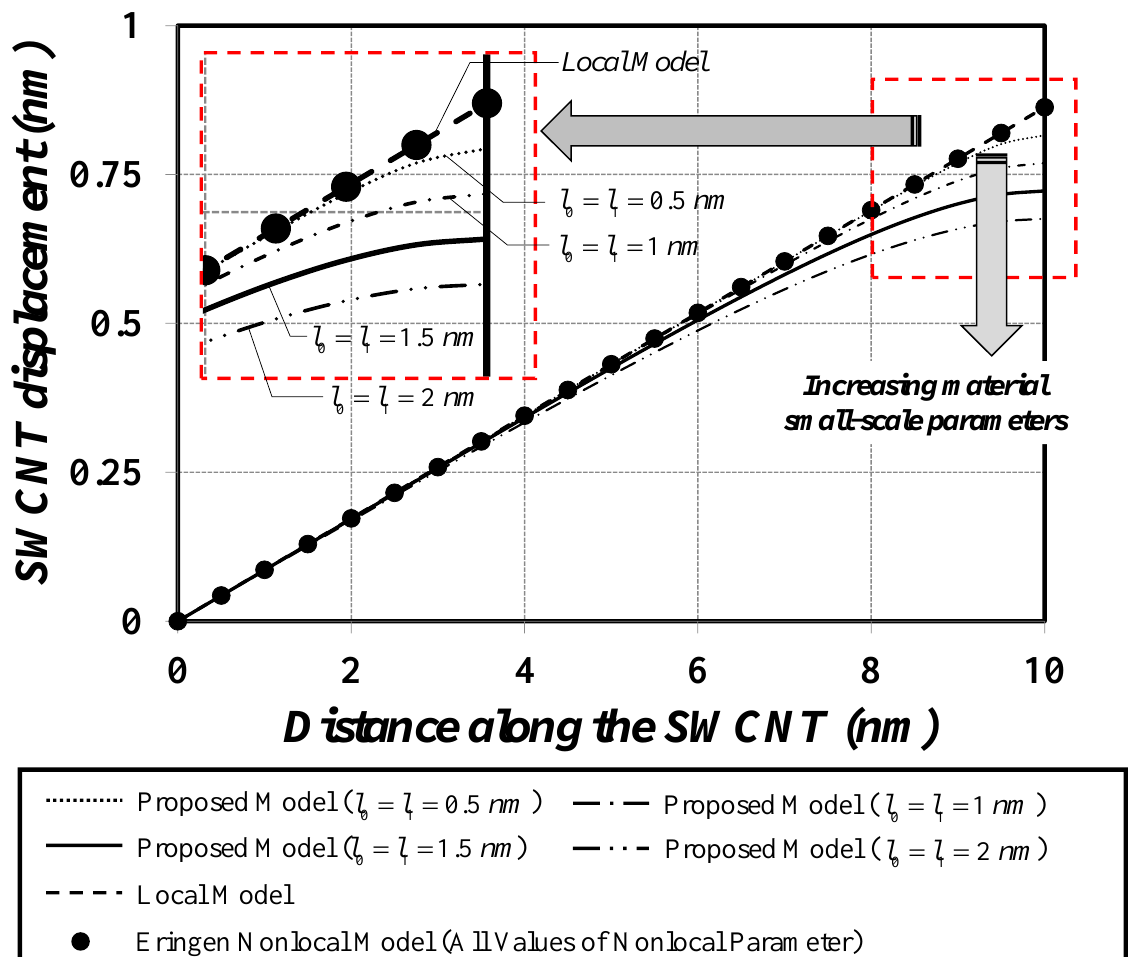
Figure 5. Axial displacement versus distance along the cantilever SWCNT under a constant axial- force state.